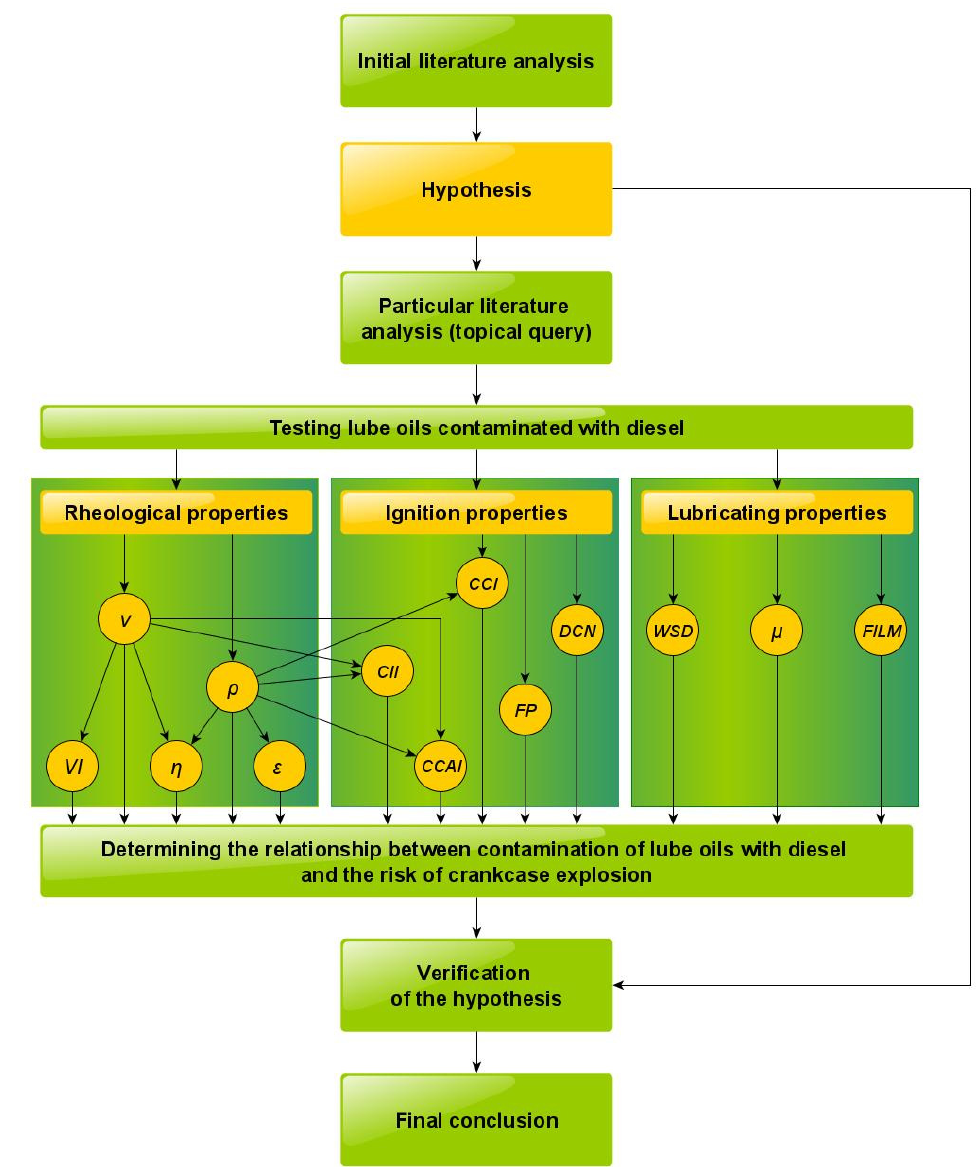
Figure 6. Research methodology adopted (description in text).